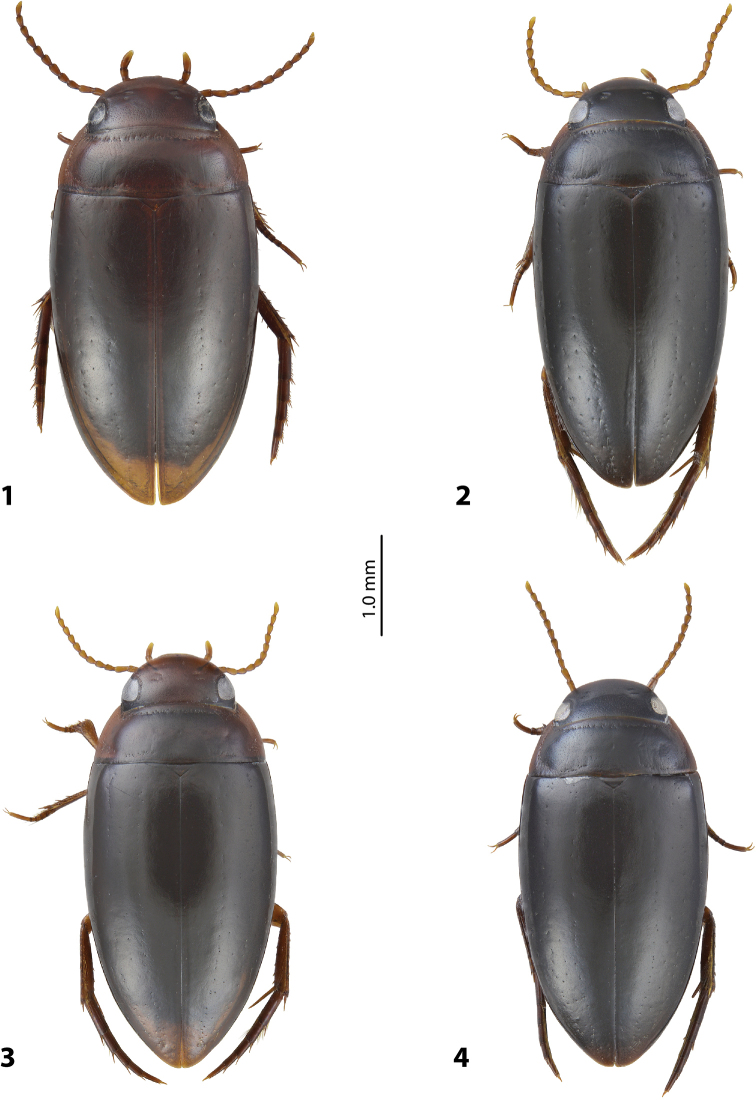
Habitus and colouration of holotype 1Exocelina
foja sp. nov. 2E.
waaf sp. nov. 3E.
riberai sp. nov. 4E.
apistefti sp. nov.